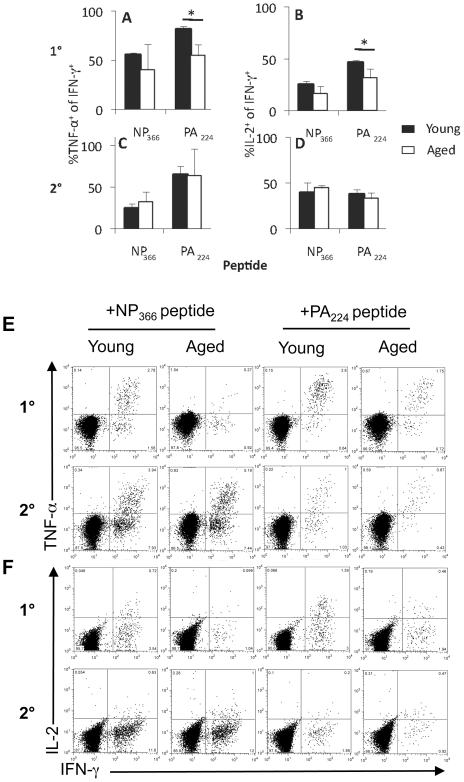
Cytokine polyfunctionality following 10 or 20 challenge.Epitope-specific CD8+ T cells generated following 10 (A, B) or 20 (C, D) i.n HK challenge (see legend to Figure 1) of young (black bar) and aged (white bar) mice were assessed for the simultaneous production of IFN-γ, TNF-α (A, C) and IL-2 (B, D) using the ICS assay. The % values (A–F) were compared for spleens from groups of 3–5 mice and representative dot plots are shown (E, F). * = p<0.05. Experimental outline as in Figure 1AB.